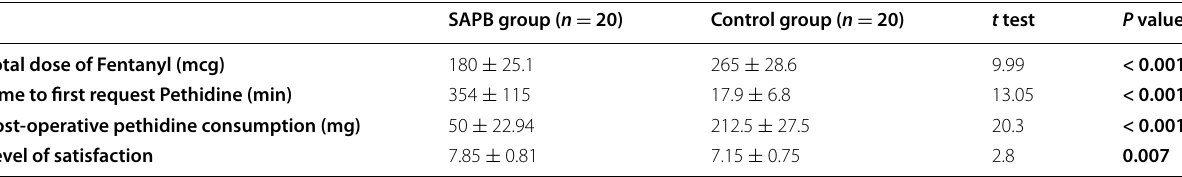
Table 2 Comparison between groups as regards total dose of fentanyl consumption, time to first request of pethidine (first rescue analgesic), total dose of pethidine consumption, and the level of